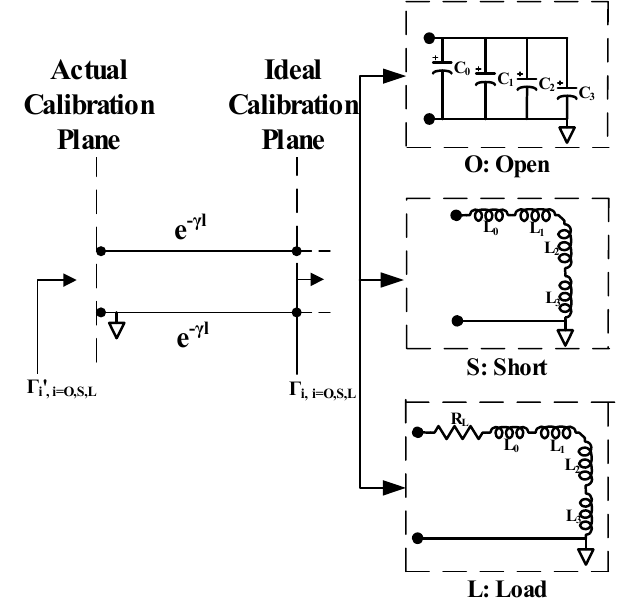
Figure 8. Schematic diagram of the Standard parameter model.